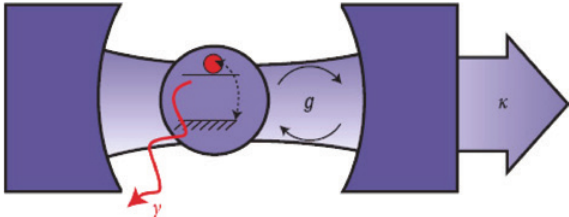
Figure 3: Characteristic parameter diagram of cavity-QED. g is the coupling coefficient of atomic and cavity EM fields. κ is the attenuation coefficient of the cavity field. γ is the dephasing rate for single two-level atom